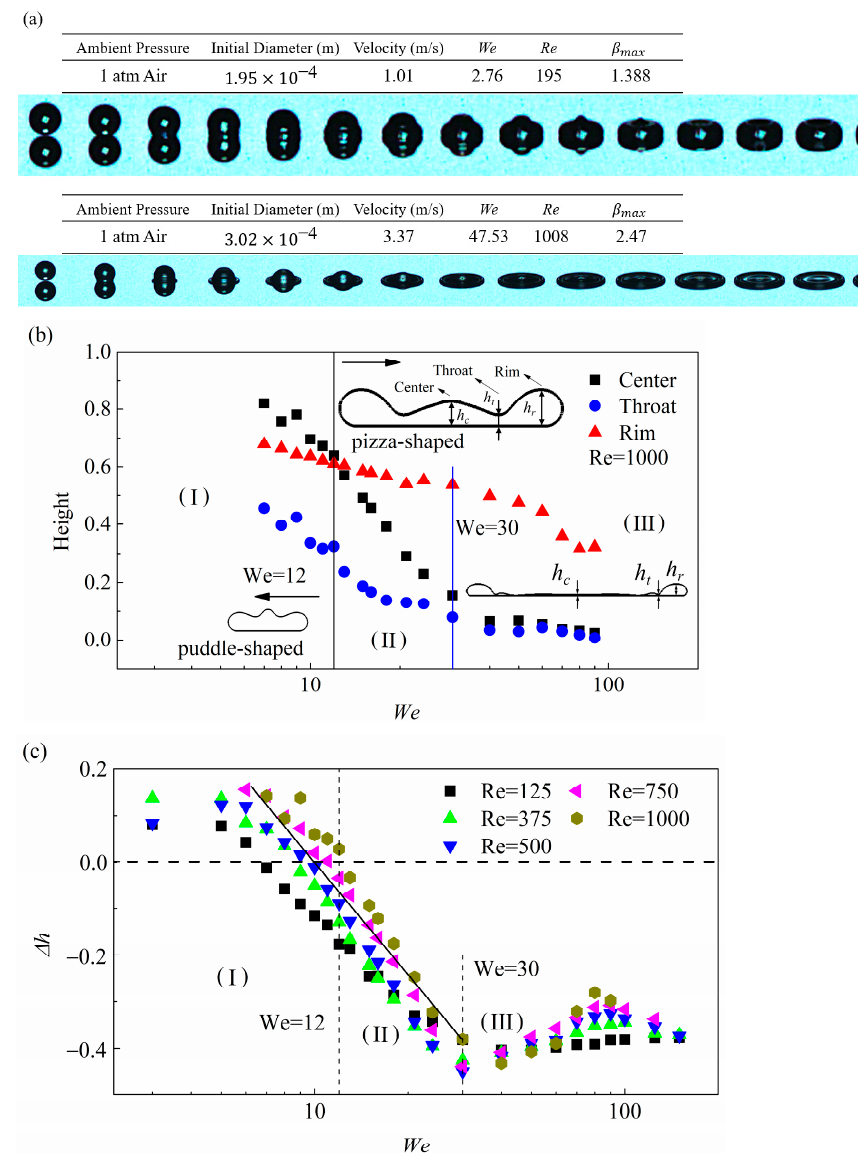
Figure 12. Schematic of droplet deformation transition characterized by different heights. ( a ) Com- parison of droplet morphology at τ max between droplet impact under small We ( We = 2.76 ) and large We ( We = 47.53 ) , ( b ) three different heights h c , h t and h r varying with We and ( c ) the difference between h c and h r i.e., ∆ h varying with We